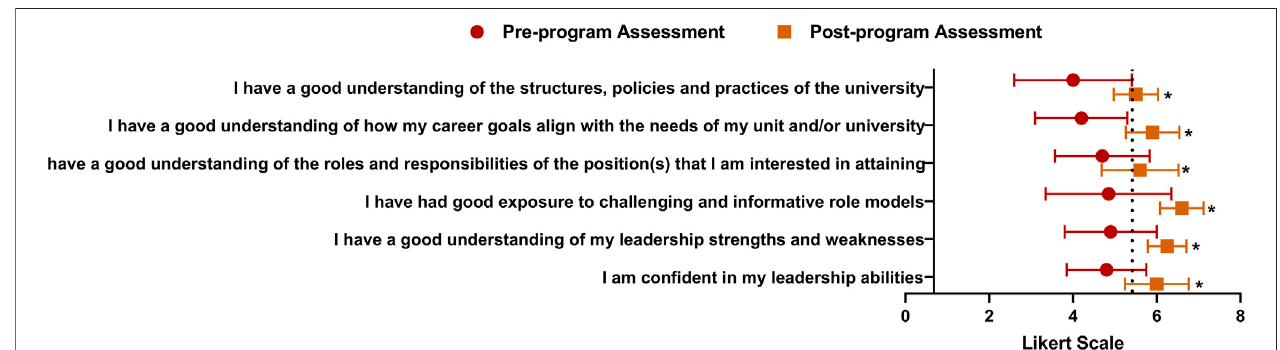
FIGURE 1 | A snaphot of self-reported gains in measures of con fi dence, leadership, career aspirations and institutional knowledge following participation in a women ’ s leadership development program. Electronic surveys were administered to the 2019 cohort (n = 25) of the Women ’ s Executive Leadership Development Program heldattheUniversityofKentuckypriortoandfollowingparticipation inthe8 monthprogram.Respondentsratedthedegreetowhichtheyagreedordisagreed with the indicated statements using Likert-scale categories from “ strongly disagree ” through “ strongly agree ” . The Likert scales were adjusted to numerical scores of 1 ( “ strongly disagree ” ) through 7 ( “ strongly agree ” ), the mean Likert scores and standard deviations were calculated for each question and statistical differences were identi fi ed by utilizing an independent samples t -test. The dashed line indicates a neutral ( “ neither agree nor disagree ” ) response. Pre-assessment responses = 20 and post-assessment responses = 8. *Signi fi cantly different ( p <